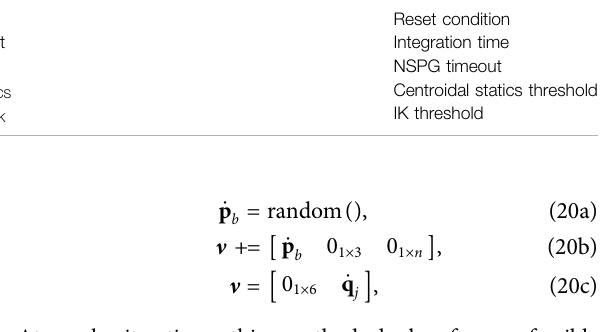
TABLE 1 | NSPG parameters.